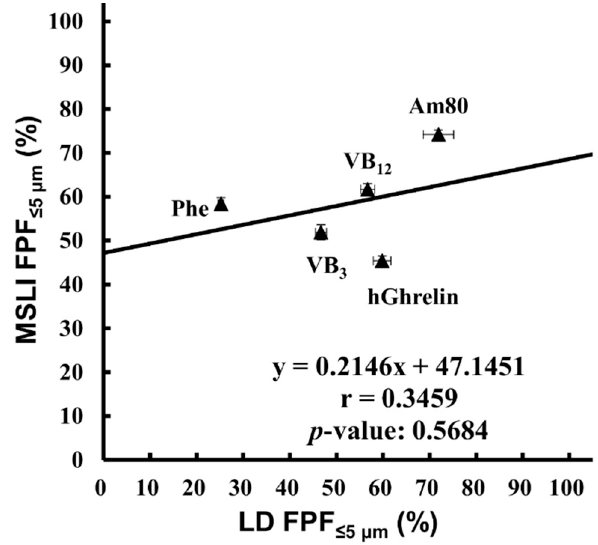
Figure 3. Correlation between MSLI FPF% ≤ 5 µ m and LD FPF% ≤ 5 µ m . Values of LD FPF% ≤ 5 µ m (mean ± S.E., n = 3) were plotted against values of MSLI FPF% ≤ 5 µ m (mean ± S.E., n = 3). MSLI, multi-stage liquid